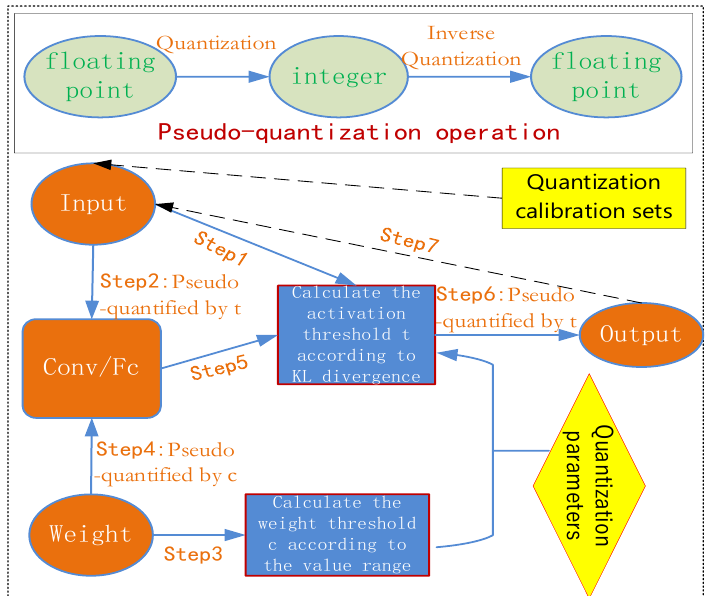
Figure 2. Overall flow chart of the quantization algorithm.